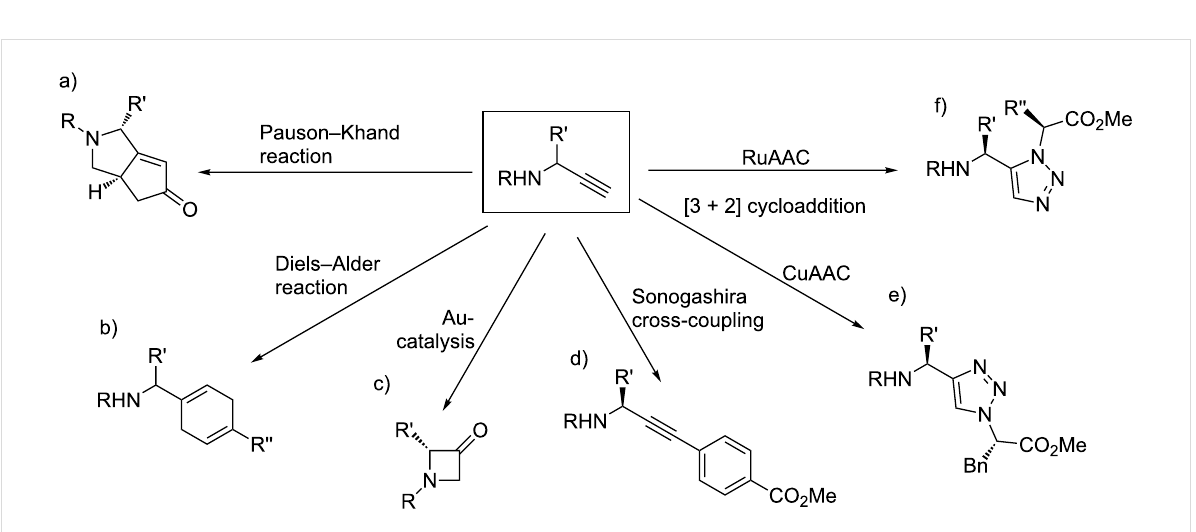
Figure 2: Selection of reactions based on propargylamines as precursors. a) Intramolecular Pauson–Khand reaction, R = ( S )- tert- butylsulfinyl, R’ = CH 2 CH 2 OTBDPS [14]. b) Diels–Alder reaction, R = p Ts, R’ = H, R’’ = Me [15]. c) Gold-catalyzed intramolecular reaction to azetidin-3-ones, R = tert -butylsulfonyl, R’ = aromatics, aliphatics [16]. d) Sonogashira cross-coupling, R = tert- butylsulfinyl, R’ = Me, CHMe 2 , CH 2 CHMe 2 , cyclohexyl [17]. e,f) Cu I or Ru II -catalyzed [3 + 2] cycloadditions (CuAAC, RuAAC) [18-21]. e) R = Boc, R’ = Bn [19]. f) R = Boc, R’ = Me, CHMe 2 , CH 2 CHMe 2 , R’’ = Me, CHMe 2 , CH 2 Ph